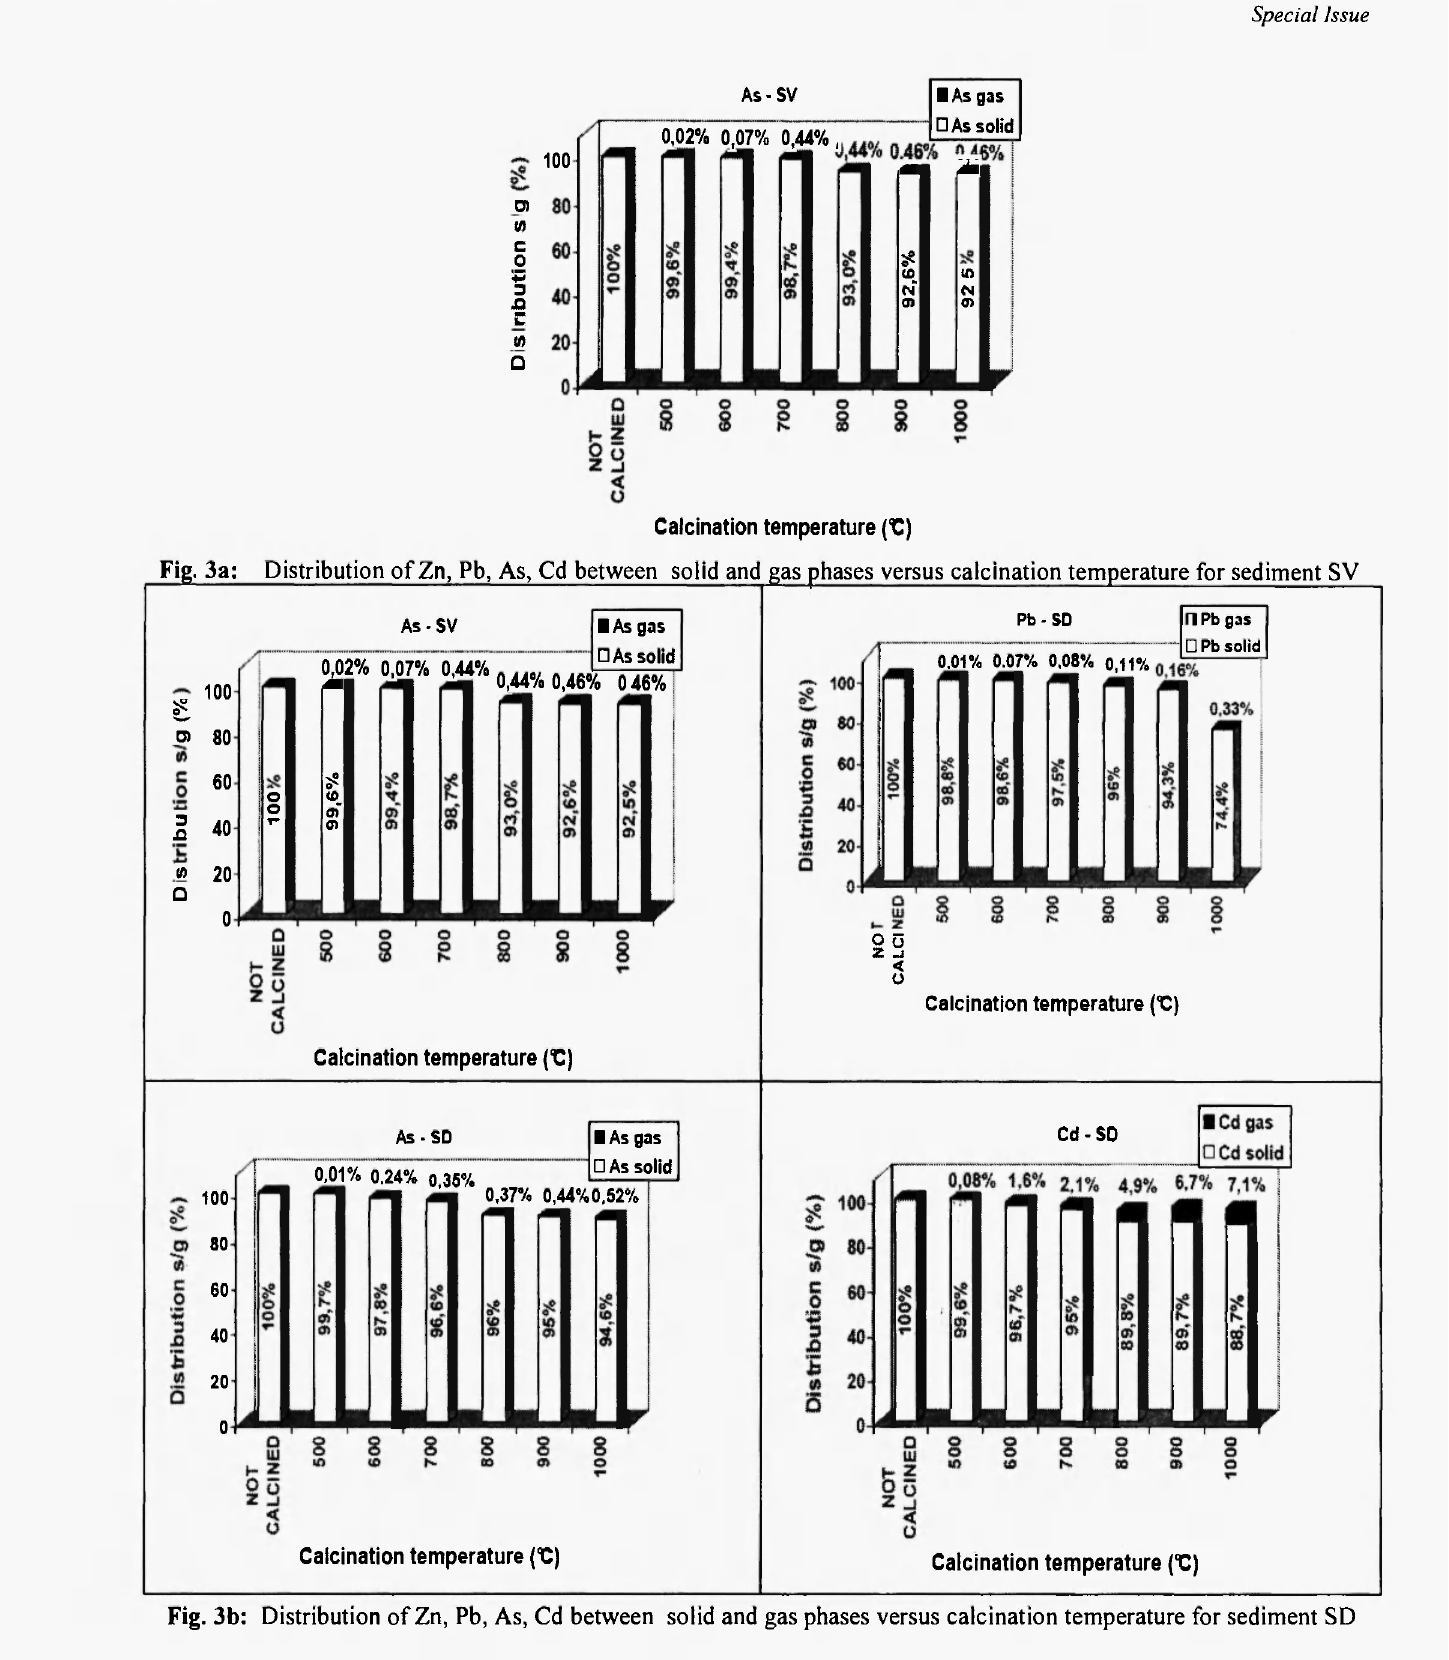
Fig. 3b: Distribution of Zn, Pb, As, Cd between solid and gas phases versus calcination temperature for sediment SD